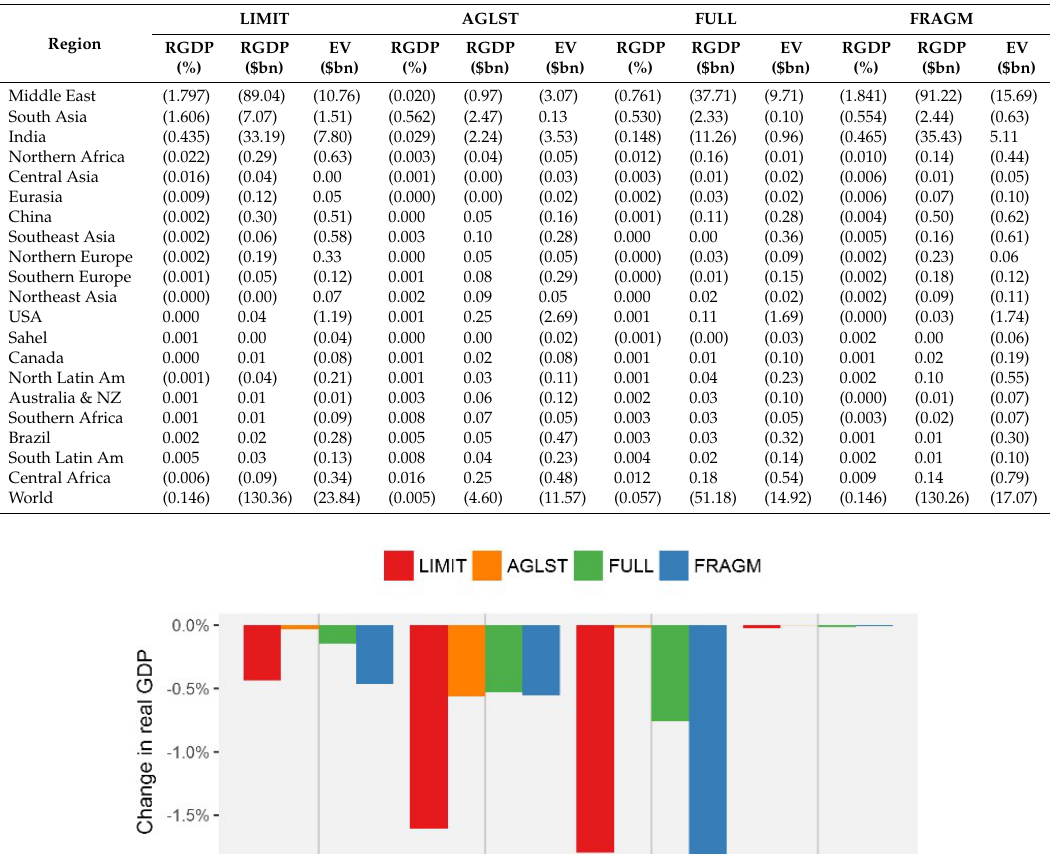
Table 2. Real GDP and equivalent variation impacts by region in 2050. The equivalent variation (EV) represents the equivalent change in household income at constant prices that would produce the same welfare effects as the change in prices obtained through the model simulations.